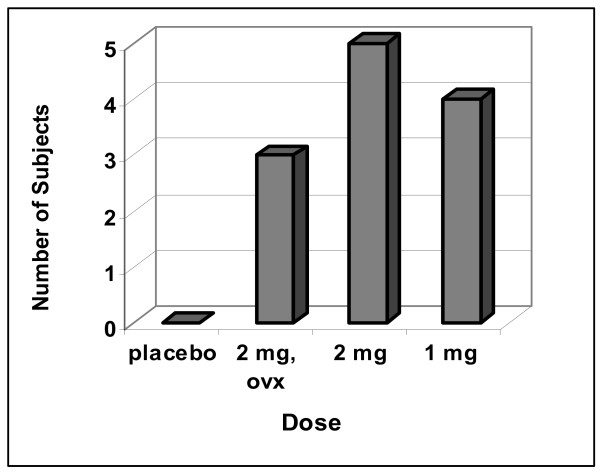
Number of Subjects taking more than 80 g'E/kg. This graph is another way of characterizing the effects of the larger doses of EV. It depicts the number of subjects taking more than 80 g'E/kg across the 5 weeks of opportunity to drink (i.e., 20 days of opportunity). 80 g'E/kg is larger than the upper limit of the range of the placebo group. Notice that 50% of the group getting 2 mg EV drank more than the most avid drinker of the placebo group.